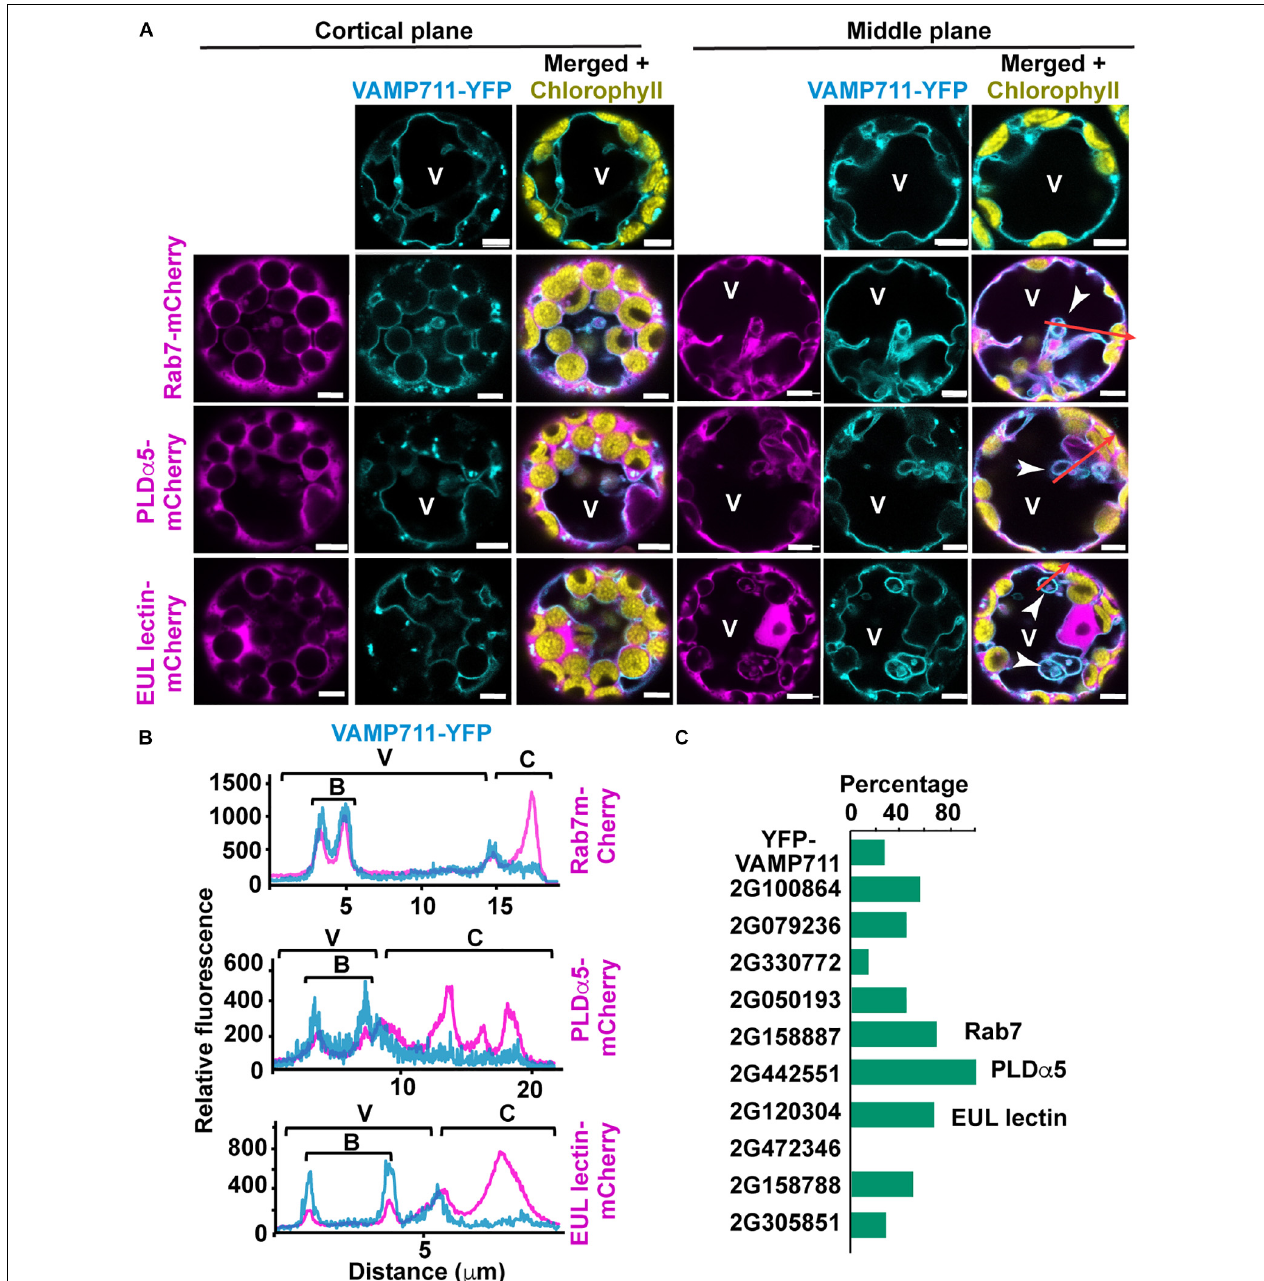
FIGURE 6 | Expression of microautophagy candidate protein in Arabidopsis leaf protoplasts. Protoplasts were isolated from leaves of transgenic plants expressing VAMP711-YFP and transformed with microautophagy candidate genes tagged with m-Cherry. (A) Representative images of cortical and middle plane views of protoplasts co-expressing VAMP711-YFP and either Rab7-, PLD α 5-, or EUL lectin- mCherry fusions. Tonoplast invagination are highlighted by white arrowheads. (B) Fluorescence intensity profiles of VAMP711-YFP and the three candidate proteins fused to mCherry along the red arrows (A) . These areas include vacuolar (V), bulb (B), and cytoplasmic (C) regions. (C) Percentage of protoplasts with rounded tonoplast invaginations or “bulbs” ( n = 7–14 protoplasts for each combination). Chart shows results from one representative experiment. V, vacuole. Scale bars = 5 µ